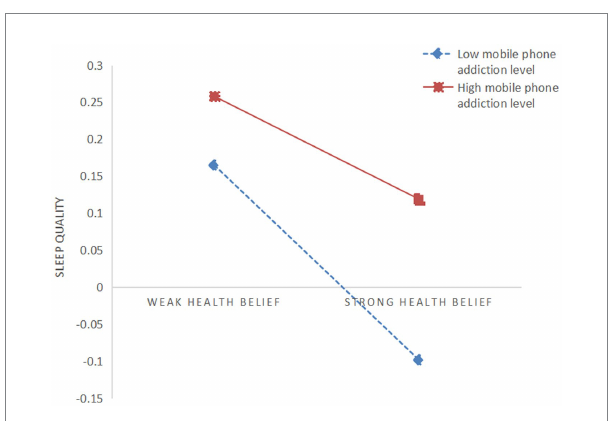
FIGURE 3 The mediating effect of mobile phone addiction on the relationship between health belief and sleep